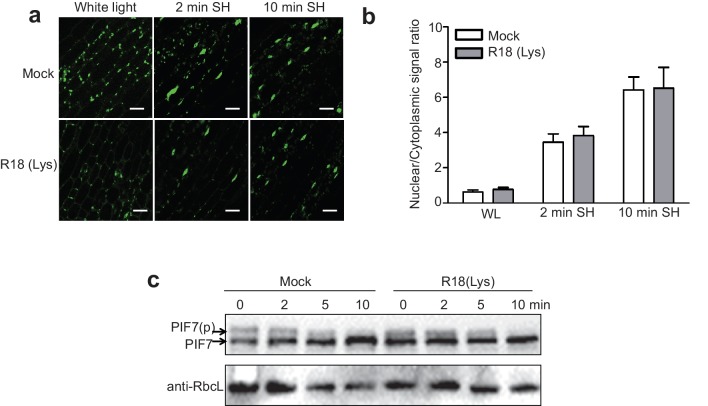
R18(Lys) is a non-functional peptide control for R18.(a) The effects of R18(Lys) and Mock on shade-induced nuclear localization of GFP-PIF7 do not differ. GFP-PIF7 #14 transgenic plants grown under white light were treated with R18 or R18(Lys) for 3 hr after 10 min of vacuum, and transferred to shade for the indicated periods. White scale bar represents 25 μM. (b) Quantification of the shade-induced nuclear accumulation of GFP-PIF7. ImageJ was used to quantify the fluorescence intensities. Ratios of the nuclear and cytoplasmic signal intensities were calculated from 10 cells for each treatment. (c) The effects of R18(Lys) and Mock on the shade-induced de-phosphorylation of PIF7-Flash. Five-day-old 35S::PIF7-Flash transgenic seedlings were treated with R18 or R18(Lys) for 3 hr after 10 min of vacuum under white light, and transferred to shade for indicated time. The level of PIF7-Flash was detected using anti-Myc antibody. RbcL was used as a loading control.